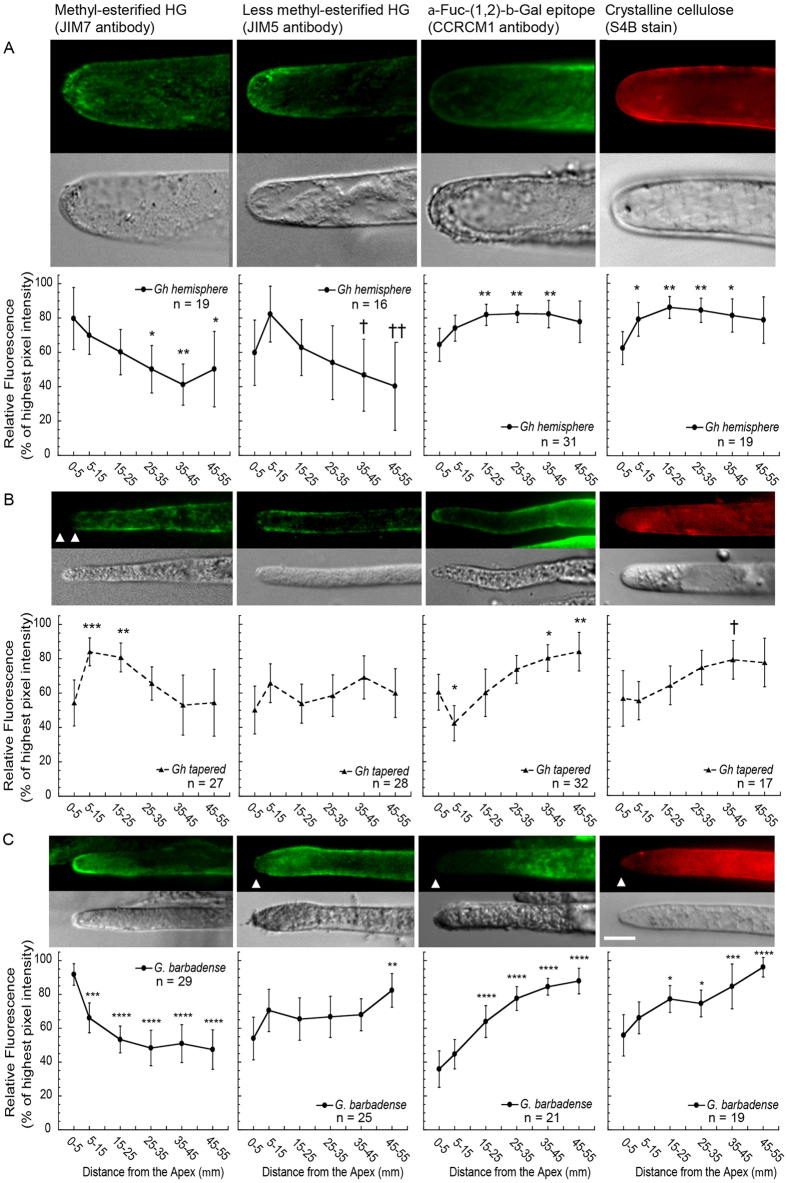
Distribution of characteristic epitopes of homogalacturonan (HG) and xyloglucan (XG) and of cellulose in diverse 4 DPA tips.Cell wall probe names are indicated at the top and the X-axis label is indicated at the bottom of each column. Fluorescent (maximum Z-projections) and brightfield images are shown for representative tips, whereas average values for the tip population are graphed. Significant differences are typically comparisons of each region with the apex (0–5 μm) as indicated by one to four asterisks (P ≤ 0.05, 0.01, 0.001, or 0.0001, respectively). Alternatively, one or two daggers indicate significance compared to the 5–15 μm region (P ≤ 0.05 or 0.01). (A) Gh hemisphere
tips: HG with relatively high methyl-esterification was enriched near the apex, with lower levels at 25–55 μm in the distal region. HG with relatively low methyl-esterification was also enriched near the apex, and then decreased in the 35–55 μm regions. The α-Fuc-(1,2)-β-Gal epitope was depleted at the apex compared to the 15–45 μm regions. Cellulose was lowest at the apex and higher in the 5–45 μm regions. (B) Gh tapered
tips: HG with relatively high methyl-esterification was depleted at the apex as compared to the 5–25 μm regions. The average amount of HG with relatively low methyl-esterification did not change with distance from the apex. The α-Fuc-(1,2)-β-Gal epitope was lower at 5–15 μm but significantly higher in the 35–55 μm regions as compared to the apex. Cellulose was lowest near the apex and significantly higher in the 35–45 μm region. (C) Gb tips: HG with relatively high methyl-esterification was most abundant at the fiber apex. The average content of HG with relatively low methyl-esterification was significantly different from the apex only at 45–55 μm. The α-Fuc-(1,2)-β-Gal epitope and the cellulose content were both significantly higher at 15–55 μm compared to the apex. Scale bar = 10 μm applies to all images. Values were graphed at the midpoint of the region measured. Error bars: 95% confidence intervals for (n) fibers analyzed.